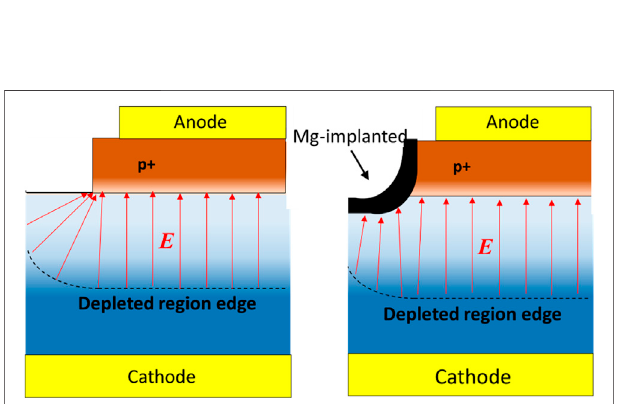
FIGURE 4 | The electric fi eld in the reverse-biased p-n diodes: (A) withoutand (B) withedge termination. Toenhance theavalanche robustness, edge terminations are required to enable more uniformly distributed electric fi elds, which can be indicated by more uniform electric fi eld lines around the device in the fi gure.